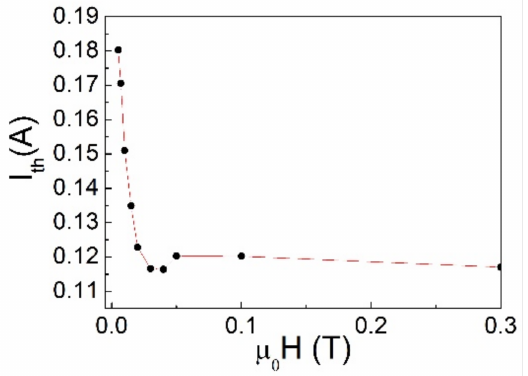
Figure 3. Behavior of I th at different applied magnetic fields in a. Nb/Al 1 − x O x /Pd 0.84 Ni 0.16 trilayer, when biasing the sample in the Nb layer (the dashed line is a visual guide).